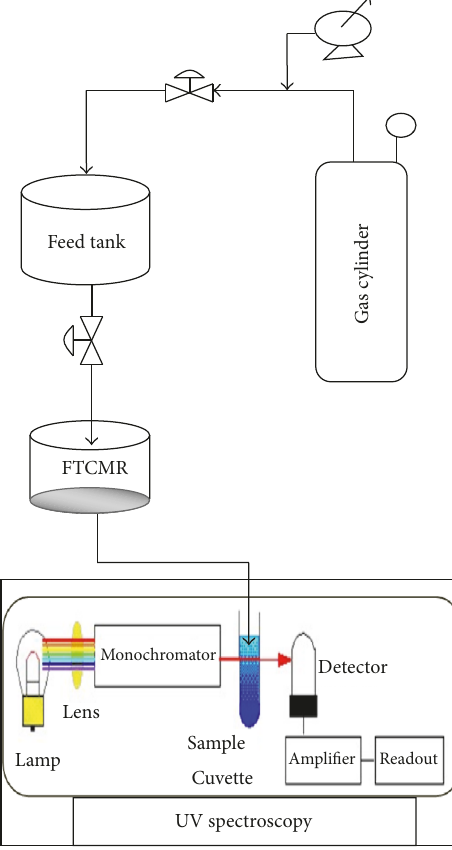
Figure 1: FTCMR experimental